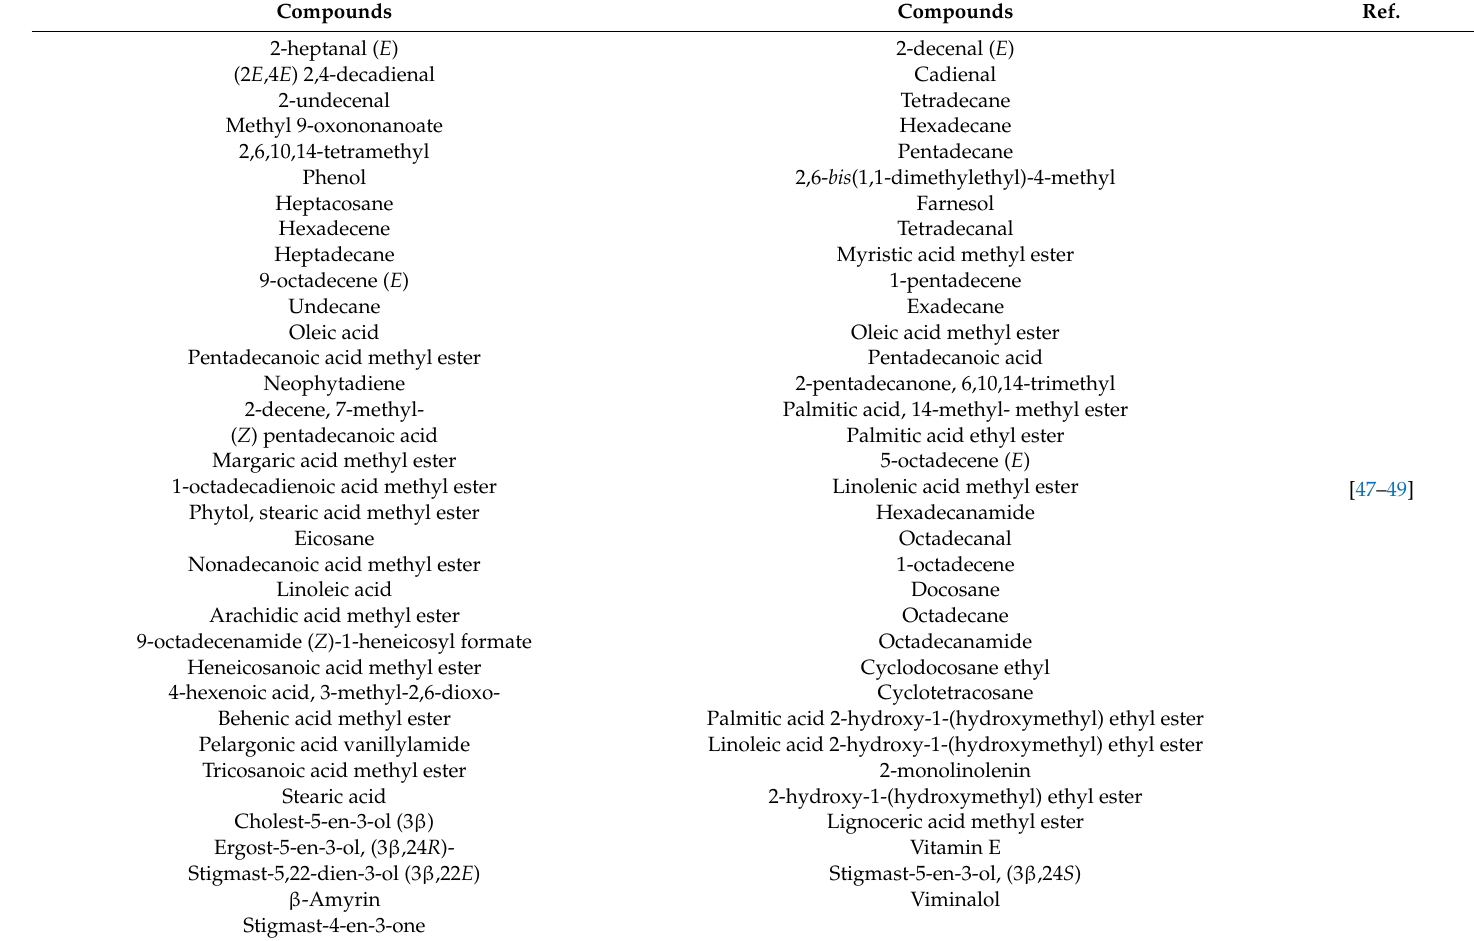
Table 3. Chemical constituents of n -hexane C. annuum